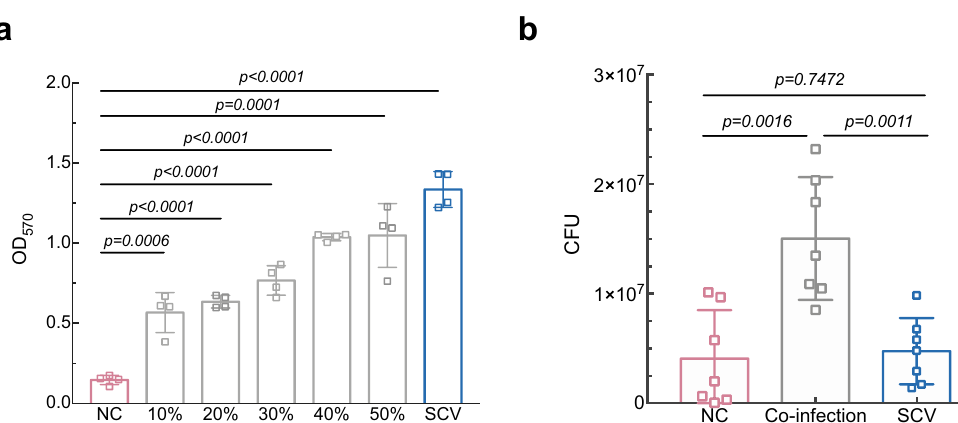
Fig. 7 Bene fi cial effect of S. epidermidis stable SCV subpopulation. a Effect of S. epidermidis stable SCV subpopulation on in vitro bio fi lm formation of NC. Culture medium was inoculated with a mixture of NC and SCV to a fi nal OD 600 of 0.1 and the percentage of SCV in the inocula is indicated. Data shown are mean ± SD from four biological replicates. Unpaired Student ’ s t test was used for statistical analyses after Shapiro – Wilk normality test. b Mutual bene fi ts of stable SCV in mice subcutaneous catheter infections. The mouse model was performed with n = 7 per infection pattern. Challenging catheters for coinfection was prepared by incubation in mixed inocula of NC and SCV at a ratio of 3:2. CFU recovered from the catheters and adjacent skin tissues were counted on day 5 by plating onto sheep blood agar plates after sonication and vortex of catheters and homogenization of skin tissue samples. Error bars show mean ± SD. Unpaired Student ’ s t test was used for statistical analyses after Shapiro – Wilk normality test.